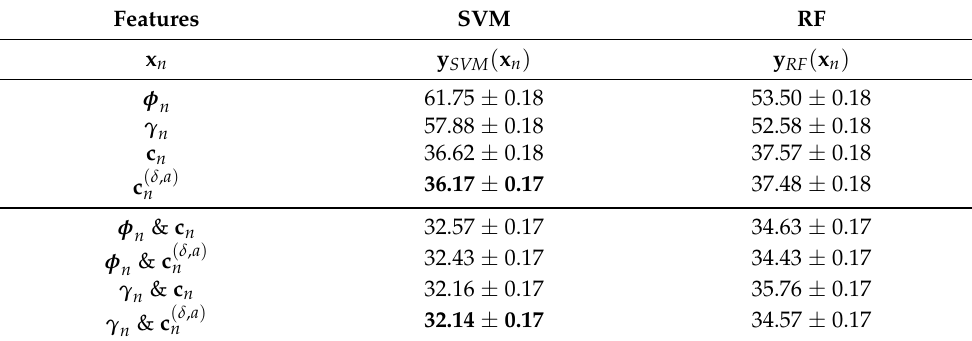
Table 1. Single heartbeat misclassification rate [%] for the university cohort. The best results are presented in